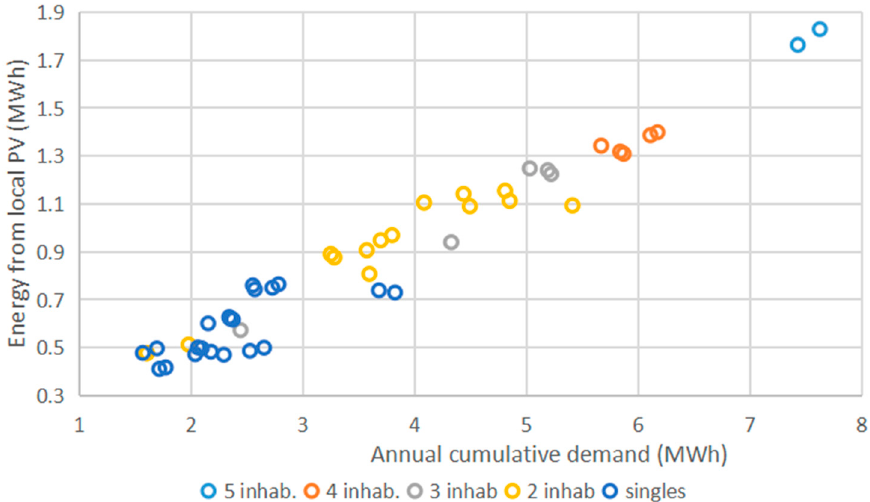
Figure A1. Relation between annual cumulative energy demand and cumulative energy received from the shared system for Scenario 1.